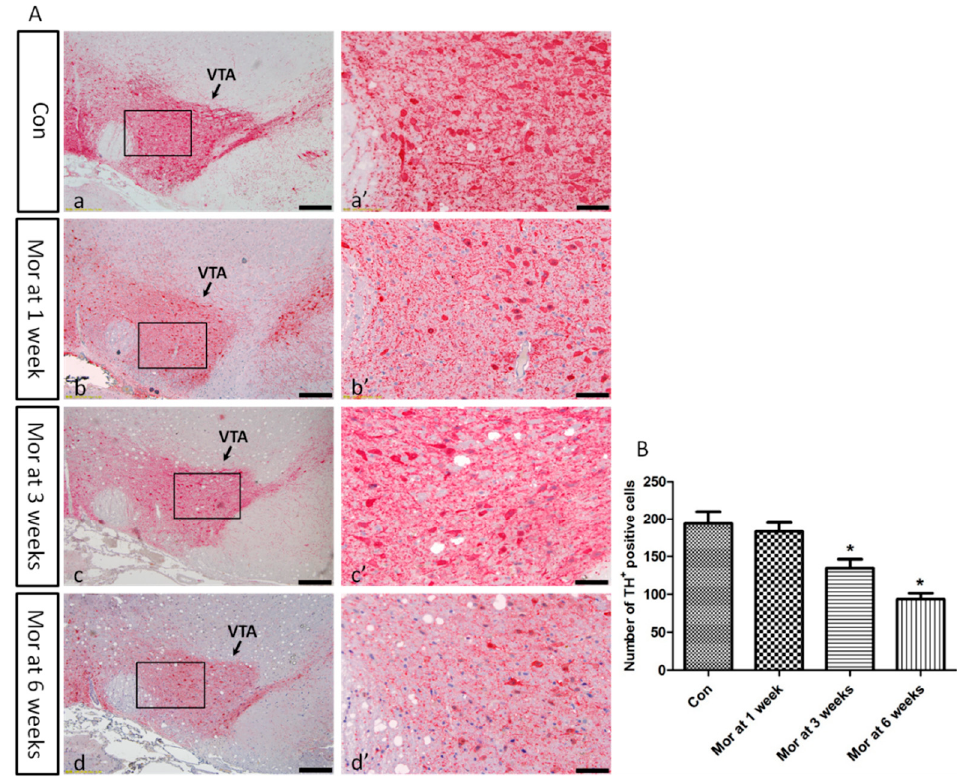
Figure 2. ( A ) Representative images showing TH immunohistochemistry in the VTA. ( a’ – d’ ) are magnified areas of ( a – d ), respectively. Bars = 100 μ m in ( a – d ); Bars = 50 μ m in ( a’ – d’ ). ( B ) Quantitative analysis of TH + positive cells. The data are shown as mean ± SEM, * P < 0.05 vs. control group ( n = 8).